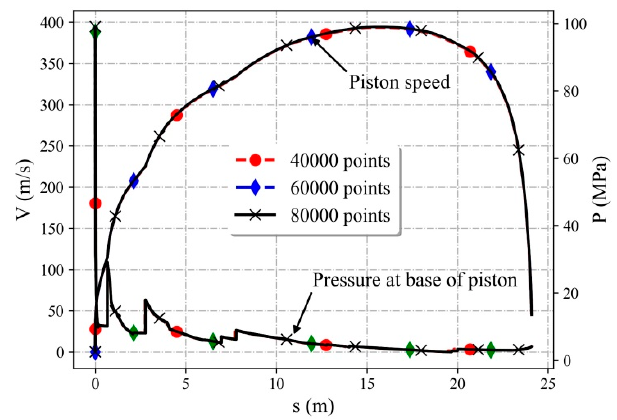
Figure 6. Speed and pressure at the base of the piston for Case 1 and three grid resolutions.